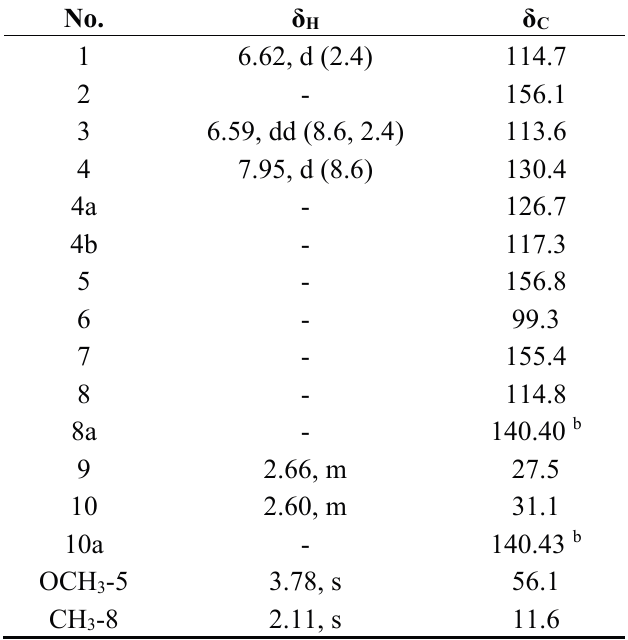
Table 1. 1 H-NMR (400 MHz) and 13 C-NMR (100MHz) data of compound 1 a